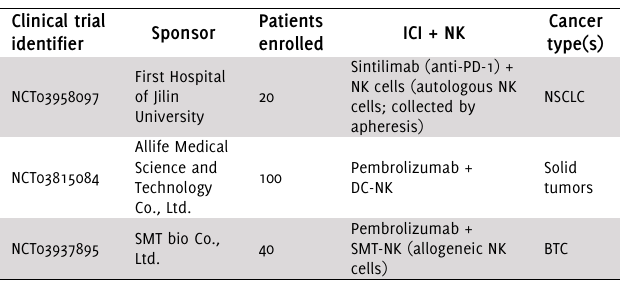
Table 3 . Clinical Trials Evaluating NK Cell Combination Therapy With PD-1